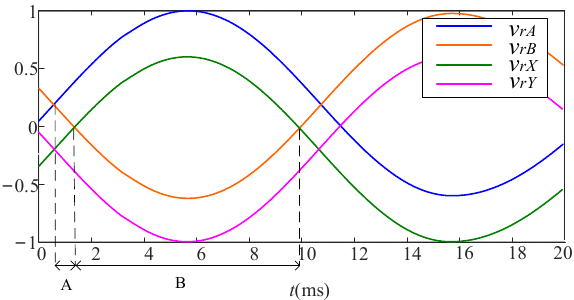
Figure 3. Reference modulated waves of ST 1 , ST 3 , ST 4 , ST 6 .